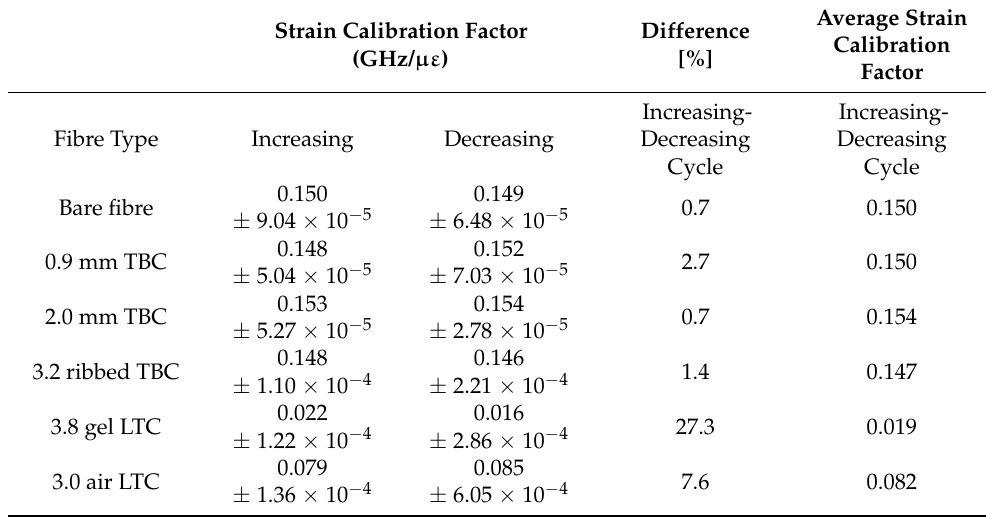
Figure 4. Increasing and decreasing strain calibration datapoints and linear fit of ( a ) bare fibre, ( b ) 900 μm tight buffered, ( c ) 2.0 mm tight buffered, ( d ) 3.2 mm ribbed tight buffered, ( e ) 3.8 mm gel filled loose tube and ( f ) 3.0 mm air filled loose tube cable. Table 3. Strain calibration factor for tight-buffered and loose-tube cables.